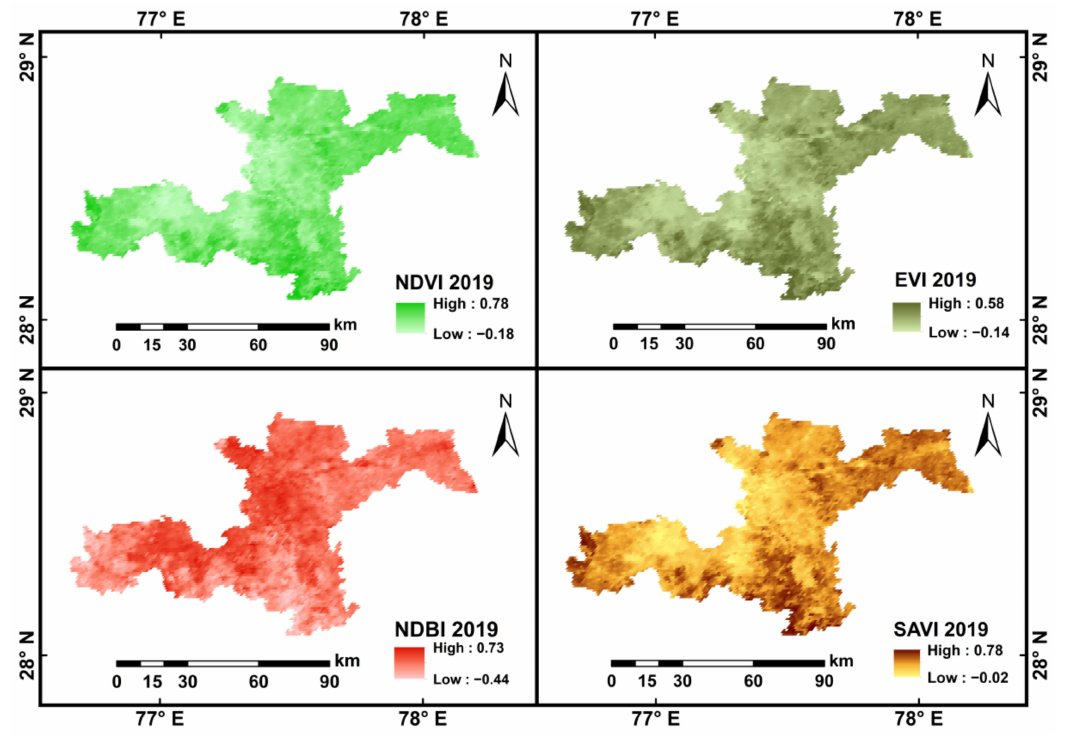
Figure 7. Maps of NDVI, NDBI, EVI, and SAVI of Aqua MODIS 2019.